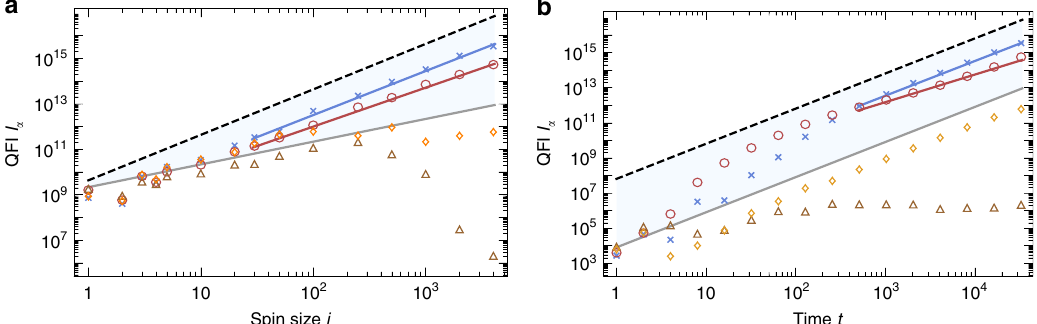
Fig. 4 Scaling of quantum Fisher information (QFI) in different areas of a mixed phase space. QFI I α ( j ) (panel a for time t = 2 15 ) and I α ( t ) (panel b for spin size j = 4000) for kicking strength k = 3 and different initial coherent states θ ; ϕ j i (as marked in panel a of Fig. 3): inside an equatorial (brown triangles, 1 : 82 ; 1 : 54 j i ) and a non-equatorial (orange diamonds, 2 : 20 ; 2 : 44 j i ) stability island, in the chaotic sea (red circles, 2 : 46 ; 0 : 32 j crosses, 2 : 56 ; 2 : 31 j i ). Benchmarks I top,CS (gray line) and I top,GHZ (black dashed line) represent the standard quantum limit and Heisenberg limit, respectively. Fits for the edge state and the state in the chaotic sea exhibit a slope of 1.94 and 1.71 for the j -scaling, and 1.98 and 1.57 for the t t > t E = ln(2 J )/ λ , with the numerically determined Lyapunov exponent λ ’ 2 : 4733, and Eq. (12) for t ≳ t H ≃ J /3 16 . We fi nd for relatively large j ( j ≳ 10 2 ) a scaling I α ∝ j 1.08 in good agreement with Eq. (12) predicting a linear j -dependence for large t ≳ t H . During the transient time t < t E , when the state is spread over the phase space, QFI shows a rapid growth that can be attributed to the generation of coherences that are particularly sensitive to the precession.